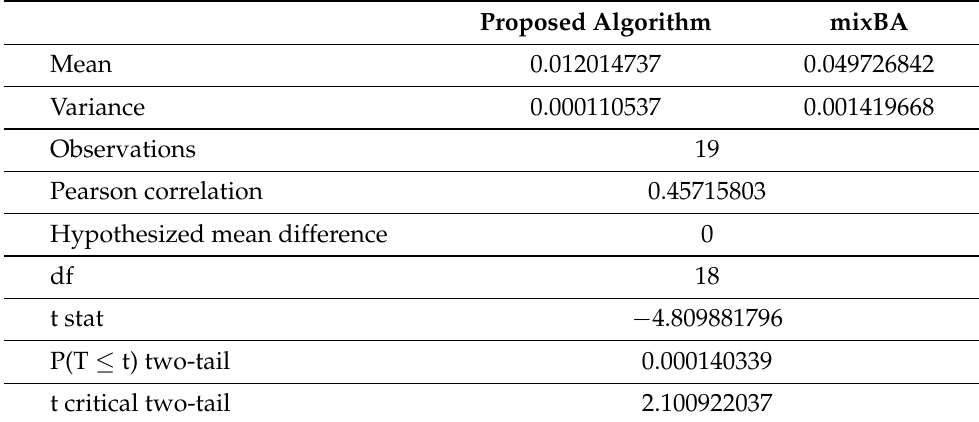
Table 2. Statistical significance of proposed algorithm and mixBA